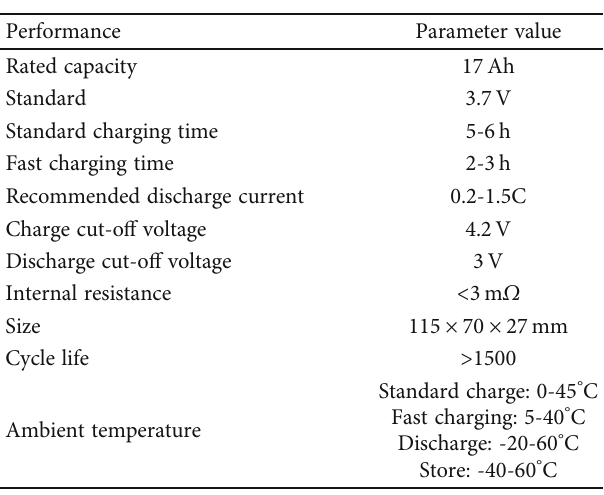
Table 5: Experimental battery